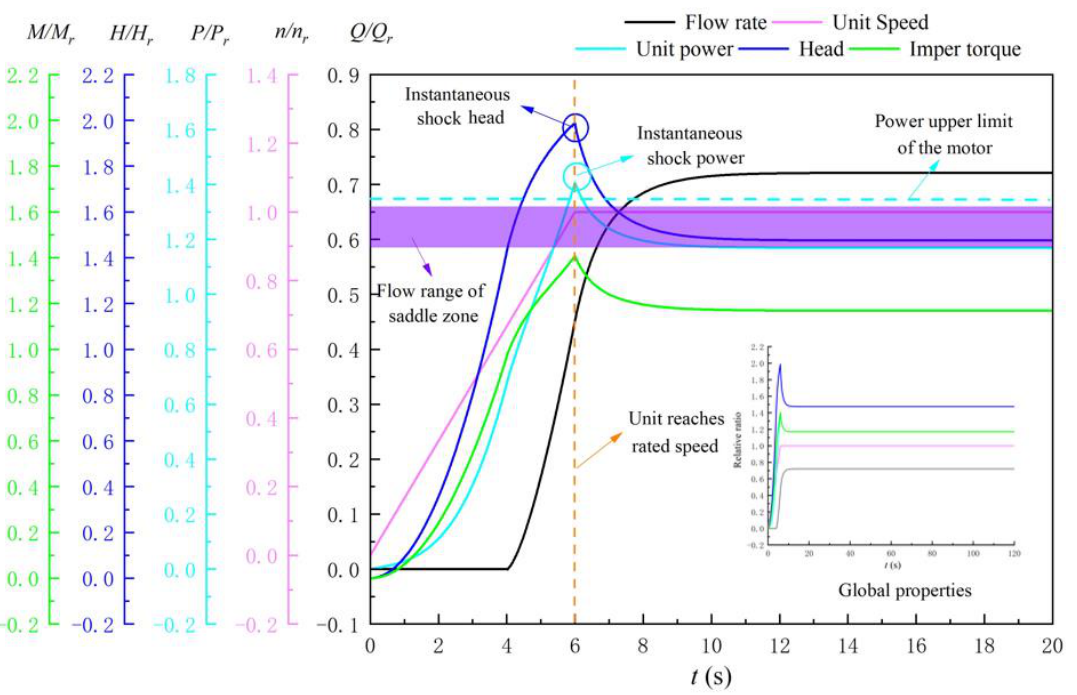
Figure 10. Start-up characteristic curve of LAPS equipped with 6.15 m OVHO elevation under gate refusal working conditions.